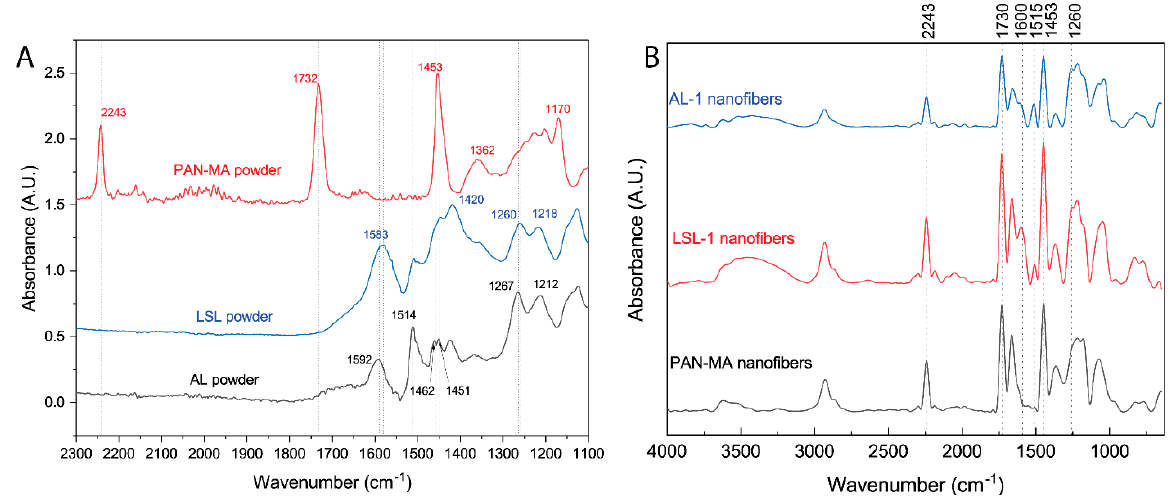
Figure 9. FTIR spectra of ( A ) LSL, AL, and PAN − MA (control) powders and ( B ) electrospun nanofibers of PAN − MA fibers (control), LSL − 1 and AL − 1. Both lignin samples had the same PAN − MA/lignin blend ratio (80/20) and were prepared at a 10 wt % concentration in DMF.